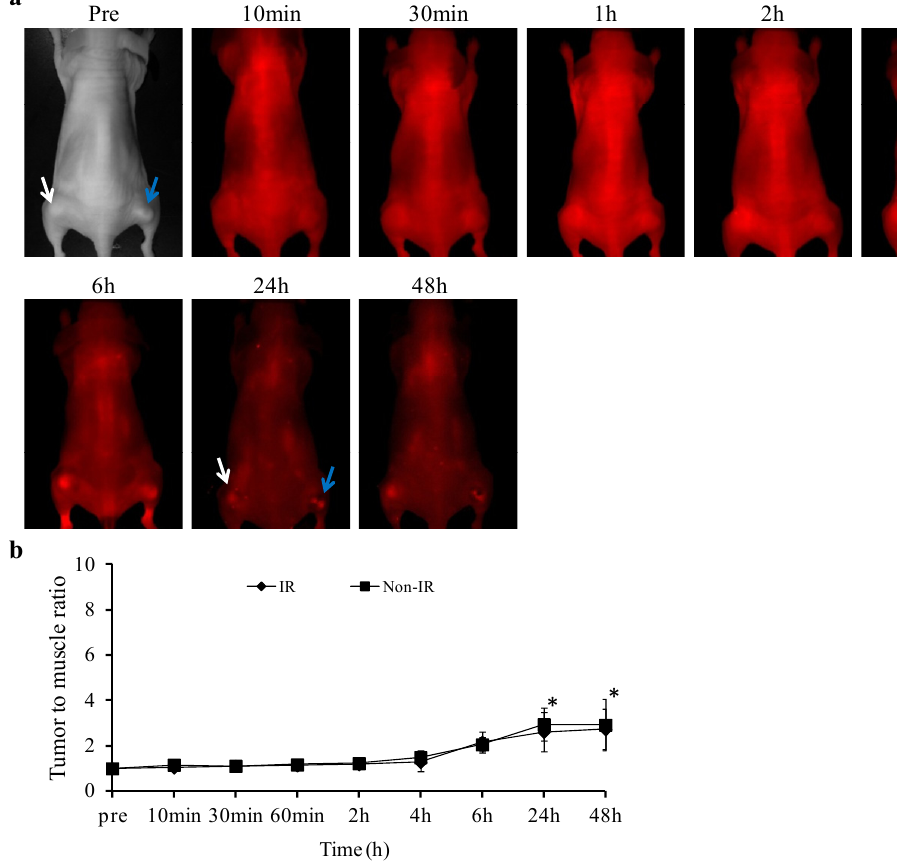
Figure 4. In vivo NIR imaging of Aur-L-800CW. ( a ) The control liposomal nanoprobes, Aur-L-800CW were injected into the mice ( n = 3) 24 h after irradiating one of the tumors on the thighs (blue arrow). A series of whole body images was acquired. Certain tumor accumulations of the probes were seen at later time points; ( b ) Quantitative analysis of TNR indicated significantly increased TNR in both the non-irradiated (white arrow) and irradiated tumors ( * p < 0.05), implicating the EPR effect causing tumor retentions of the control